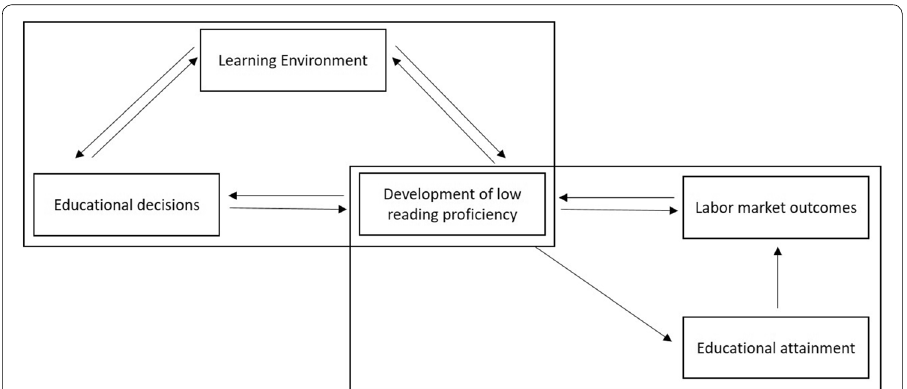
Fig. 1 Interrelation of Educational Decisions, Learning Environment, Educational Attainment, and Labor Market Outcomes with the Development of Low Reading Proficiency (modified model following Blossfeld et al. 2019, p.